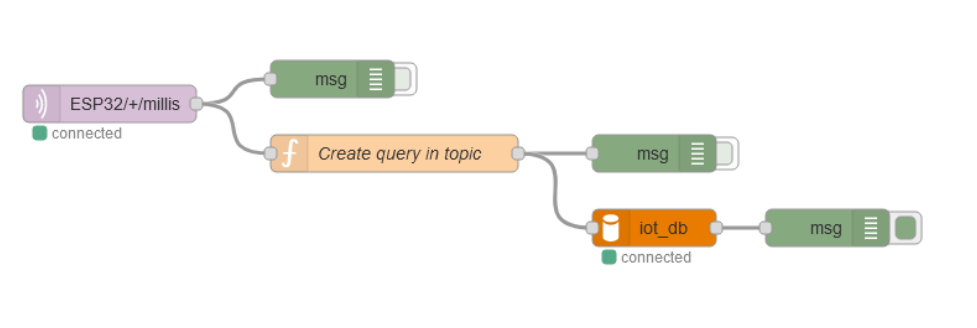
Figure 4. Node-RED data flow.